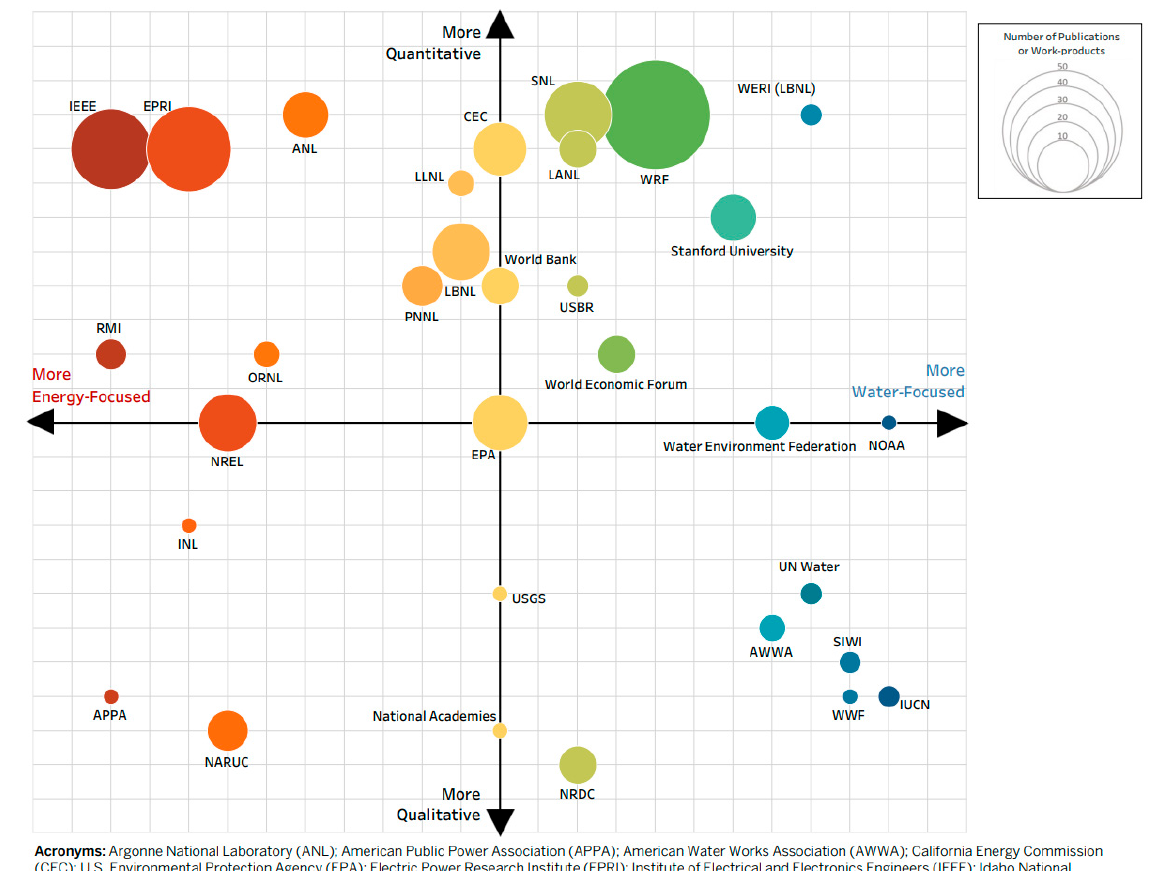
Figure 1. Coverage of the water–energy research sphere based on institutional landscape assessment results.